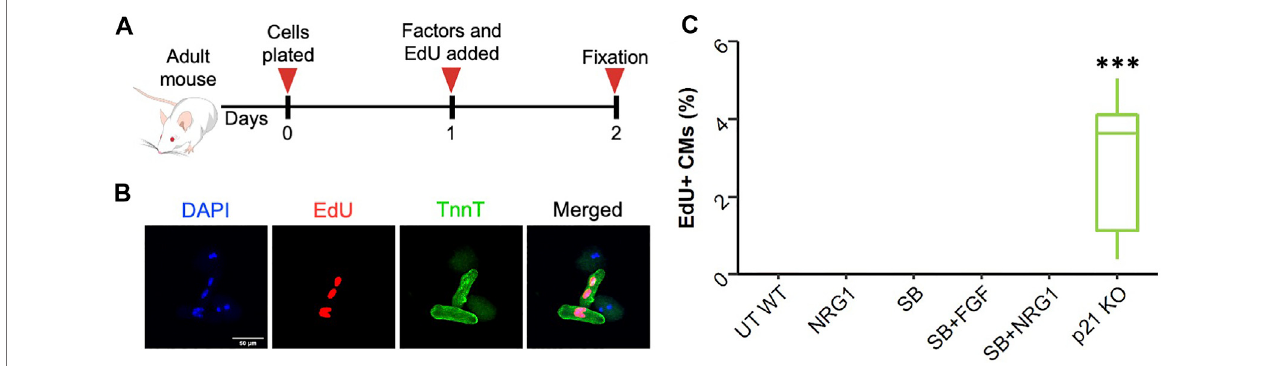
FIGURE 6 | Effect of proliferative stimuli on adult mouse cardiomyocytes. (A) Schematic overview of the experimental outline. (B) Representative images of wild typeandp21KOadultcardiomyocytes.TroponiT(green),EdU(red),DAPI(blue),scalebarequals100 µm (C) Quanti fi cationofEdU+adultmousecardiomyocytes24 h after treatments. *** p < 0.001. ( n = 9 for each